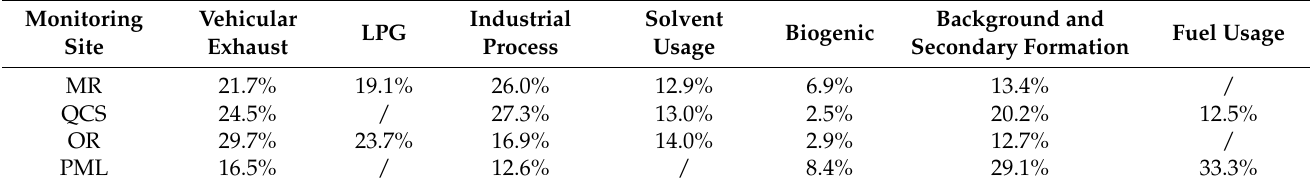
Table 3. Results of the volatile organic carbon source analysis by positive matrix